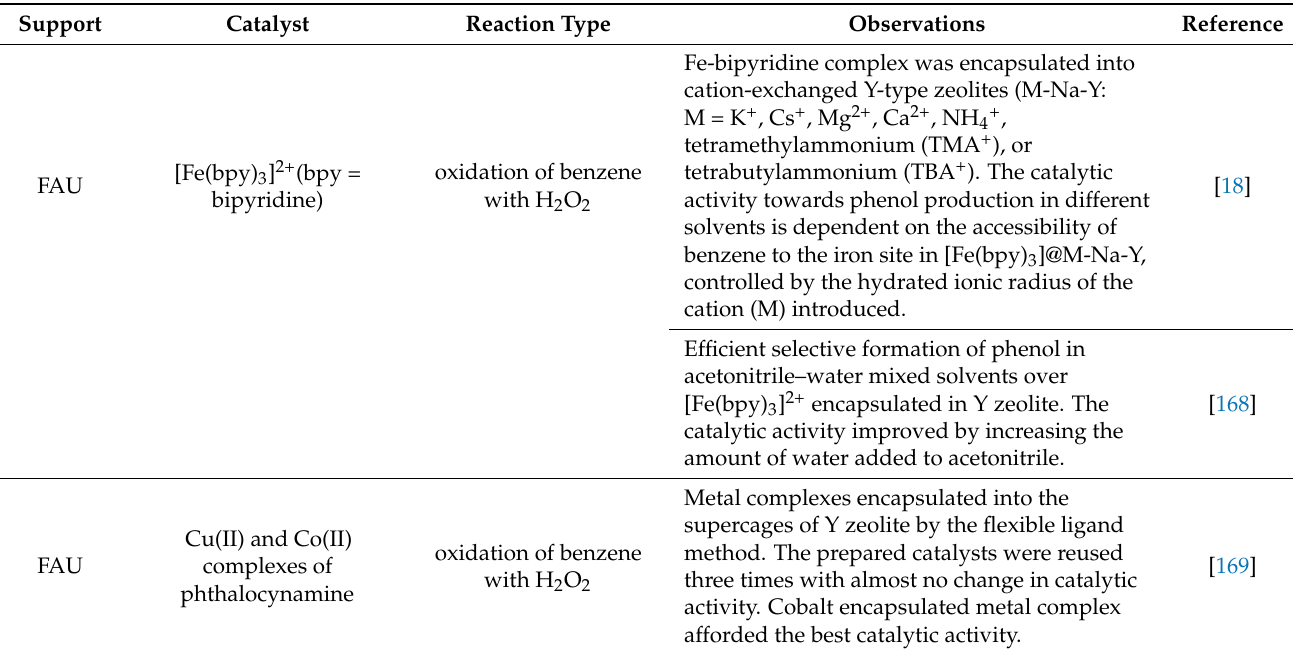
Figure 19. Structures for ( a ) Schiff base H 2 L; ( b ) [VO(L) · H 2 O]; ( c ) [Co(L) · H 2 O] · H 2 O; ( d ) Y zeo- lite pore opening; ( e ) [VO(L) · H 2 O]-Y and ( f ) [Co(L) · H 2 O]-Y. Reproduction with permission from Reference [162]. Copyright (2017) Elsevier B.V. Table 5. Commercial/hierarchical zeolites and related materials applications as catalytic supports for the oxidation of